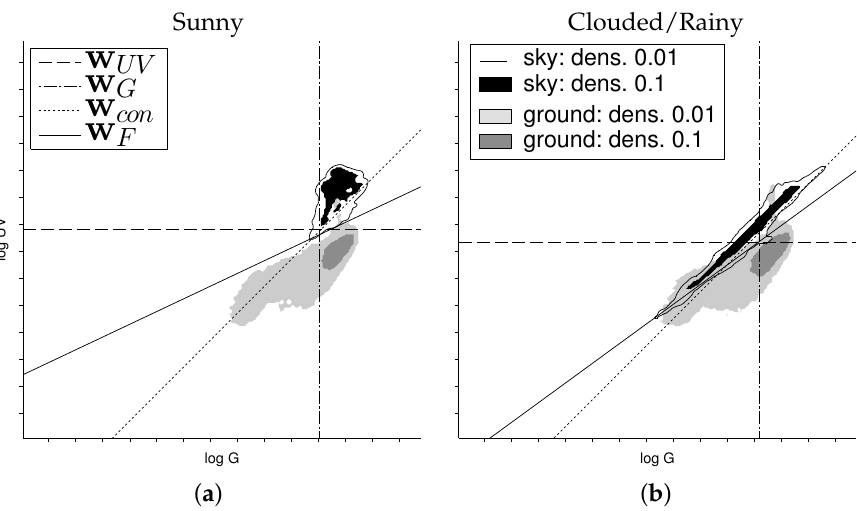
Figure 12. The plot shows the log UV/G data for the sand skyline together with the sky data (selected from all databases) of sunny days ( a ) and days where the sky was cloudy including rain ( b ). While the classification rate is similar in both cases using the Fisher discriminant w F (98.7% and 93.0%), it differs strongly for the UV-only separator w UV (98.3% and